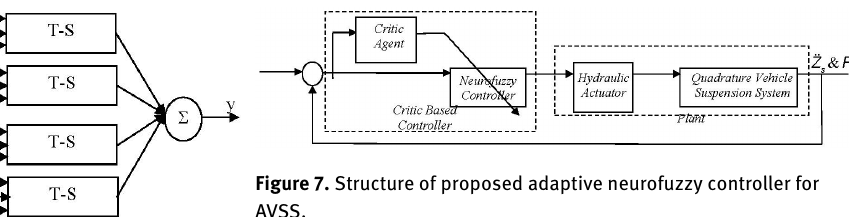
Figure 7. Structure of proposed adaptive neurofuzzy controller for